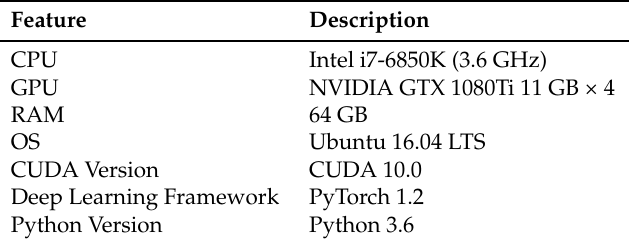
Table 3. Performance evaluation environment.